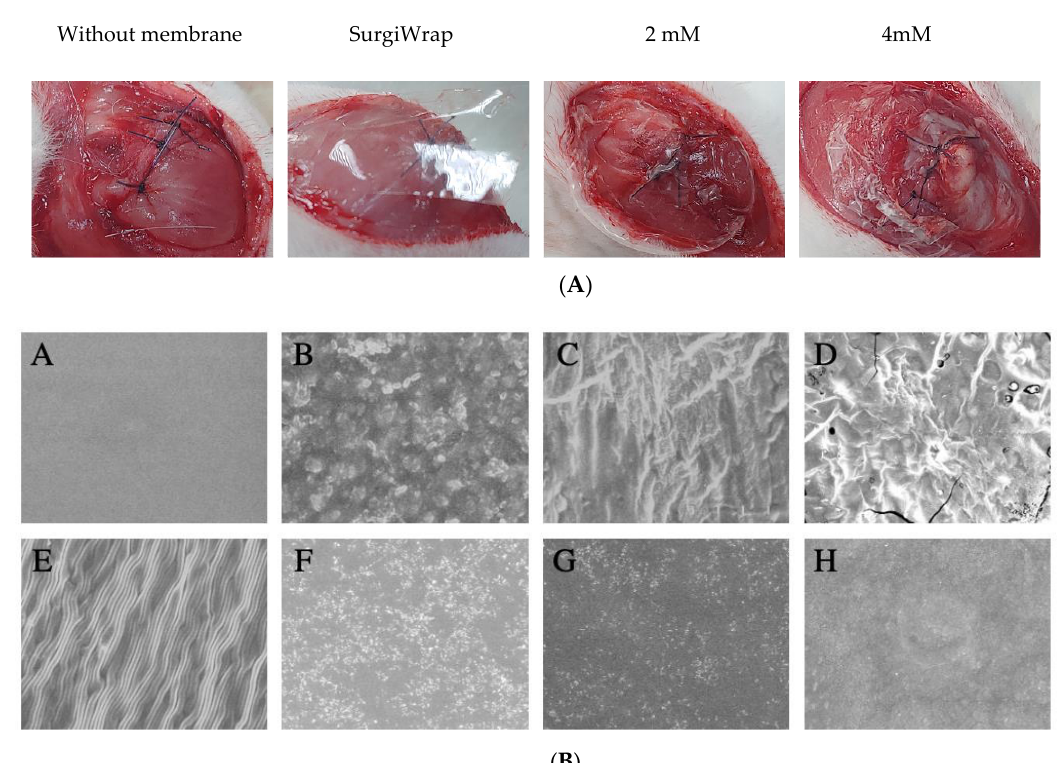
Figure 2. Basic properties of the GHF membranes; ( A ) water content; ( B ) swelling ratio, and ( C ) the degradation profiles of GHF and SurgiWrap membranes in PBS solution with a pH of 7.4 over 24 h; ( D ) the profile of the release of farnesol from the GHF membrane impregnated with 4 mM farnesol in PBS solution with a pH of 7.4 over a 10-day period. (Means  S.D) A: membrane impregnated 0 mM farnesol, B: membrane impregnated 2 mM farnesol, and C: membrane impregnated 4 mM farnesol.